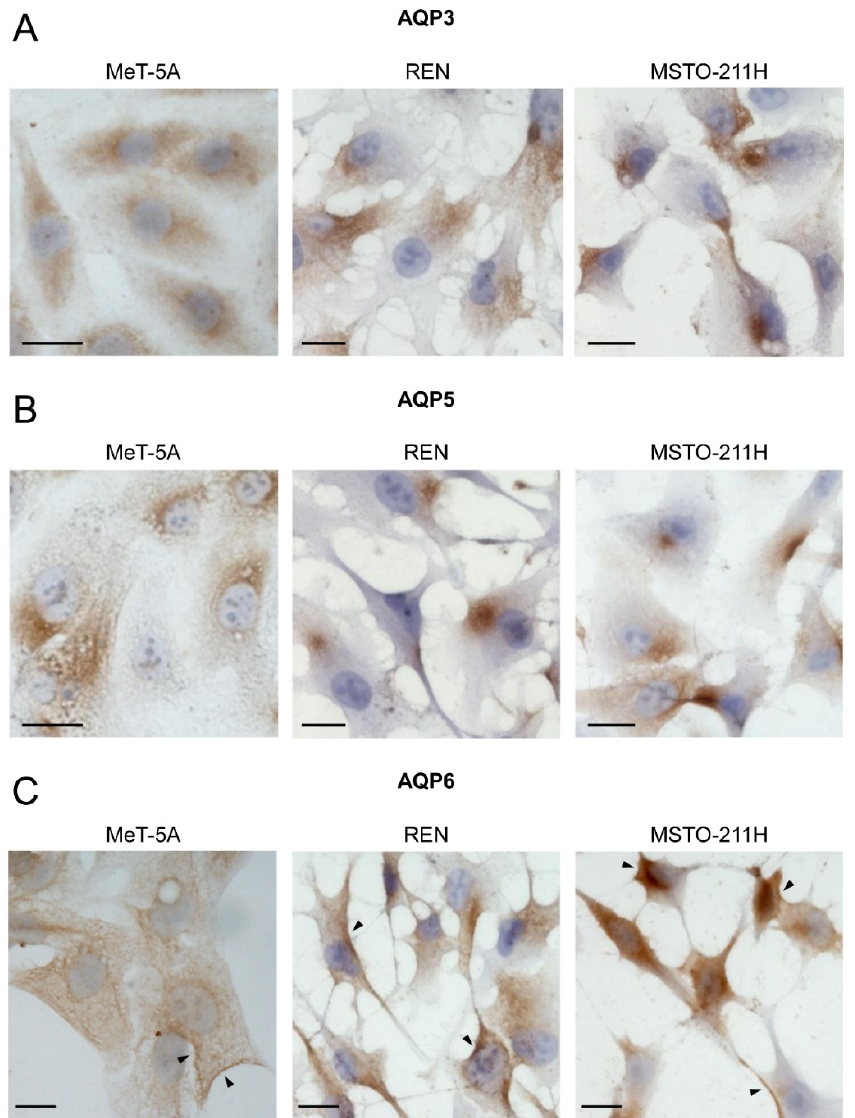
Figure 3. Immunocytochemical localization of AQP3 ( A ), AQP5 ( B ), and AQP6 ( C ) proteins in MeT-5A, REN, and MSTO-211H cell lines. AQP3 and AQP5 staining appeared to be confined mainly to intracellular structures. AQP6 staining in MeT-5A is mainly intracellular and has a low expression in the plasma membrane. REN and MSTO-211H cell lines showed strong labelling in discrete areas of the plasma membrane, in addition to the intracellular expression. Arrowheads indicate the localization in plasma membranes. Scale bar: 20 µm.